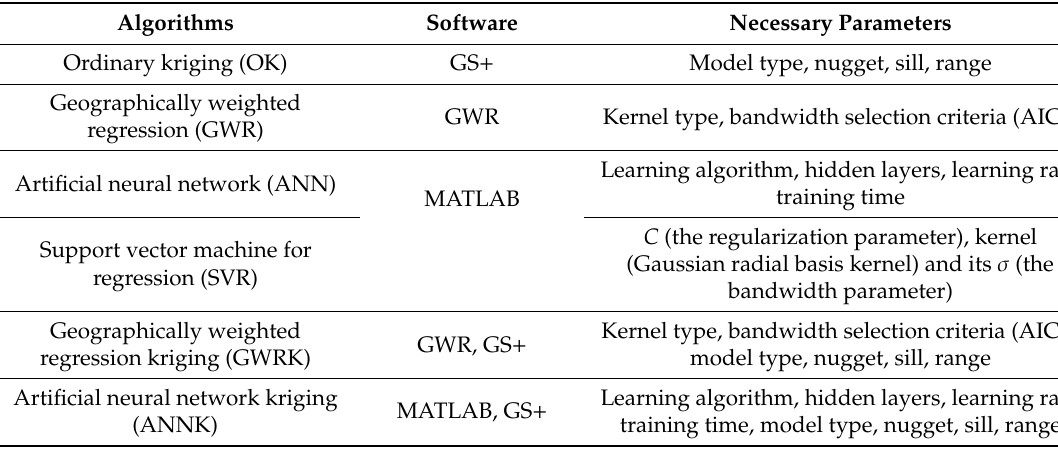
Table 2. Algorithms used in the